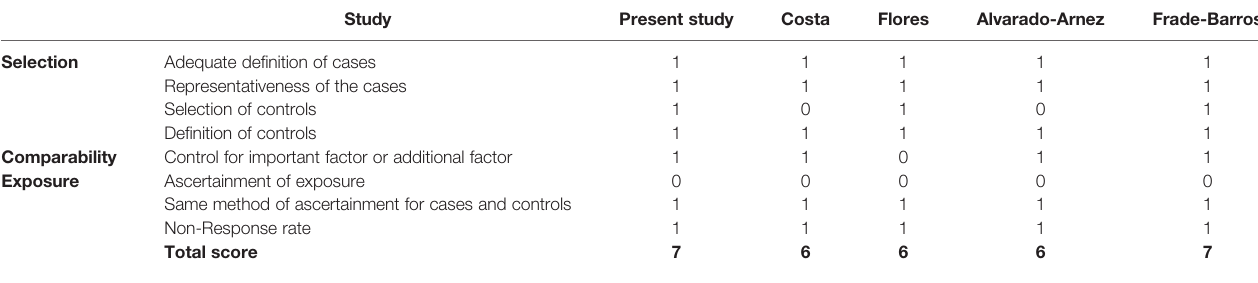
Colombian population but found no association with CCC (35).